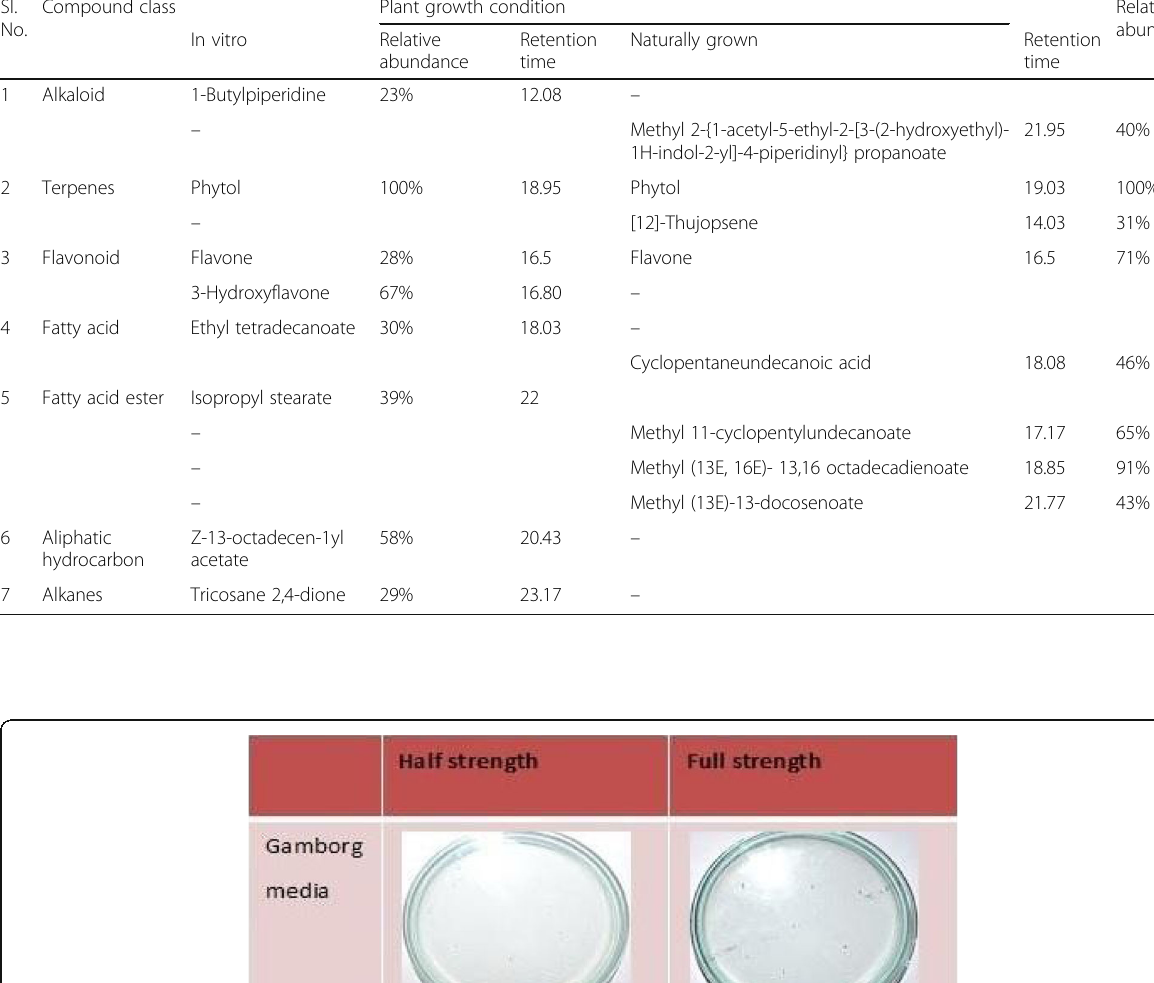
Table 4 Comparison of phytochemicals present in the in vitro and naturally grown L. cruciata Sl. Compound class No.